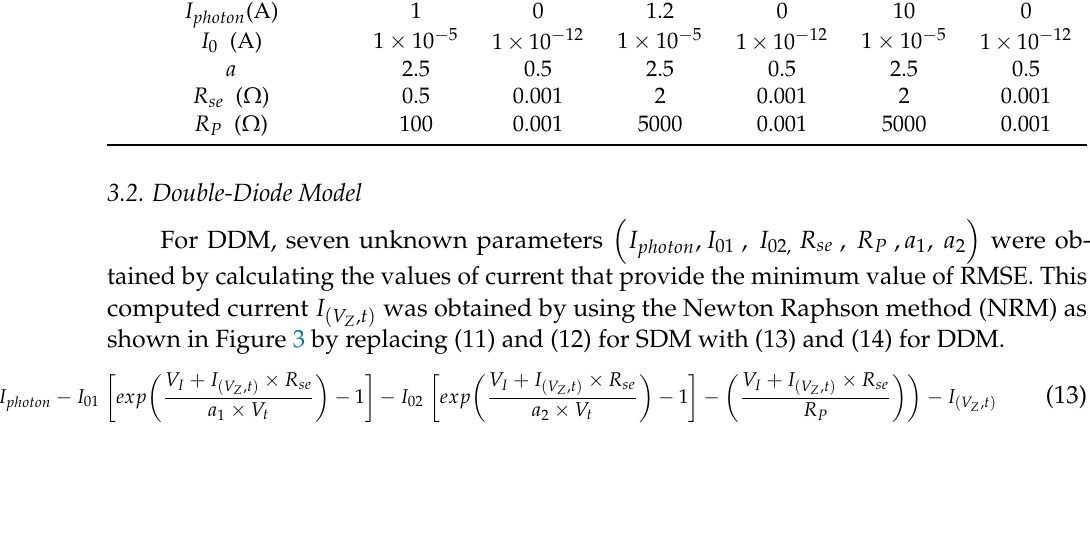
Figure 3. Newton Raphson method for the formulation of the objective function.